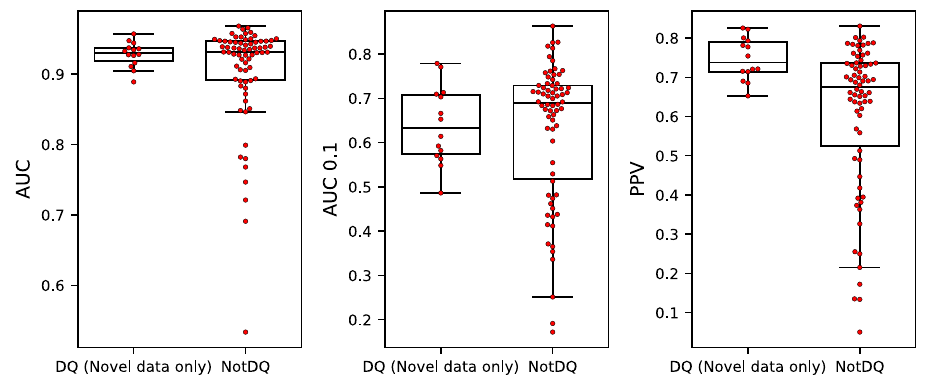
Fig. 3 Performance of the model trained including the novel data, evaluated on both the novel data alone restricted to DQ, as well as on non-DQ including the full dataset. Each point is the performance metric for an HLA class II molecule. Each boxplot shows the median inside the interquartile range (IQR) between the upper and lower quartiles, with whiskers extending to at most 1.5 times